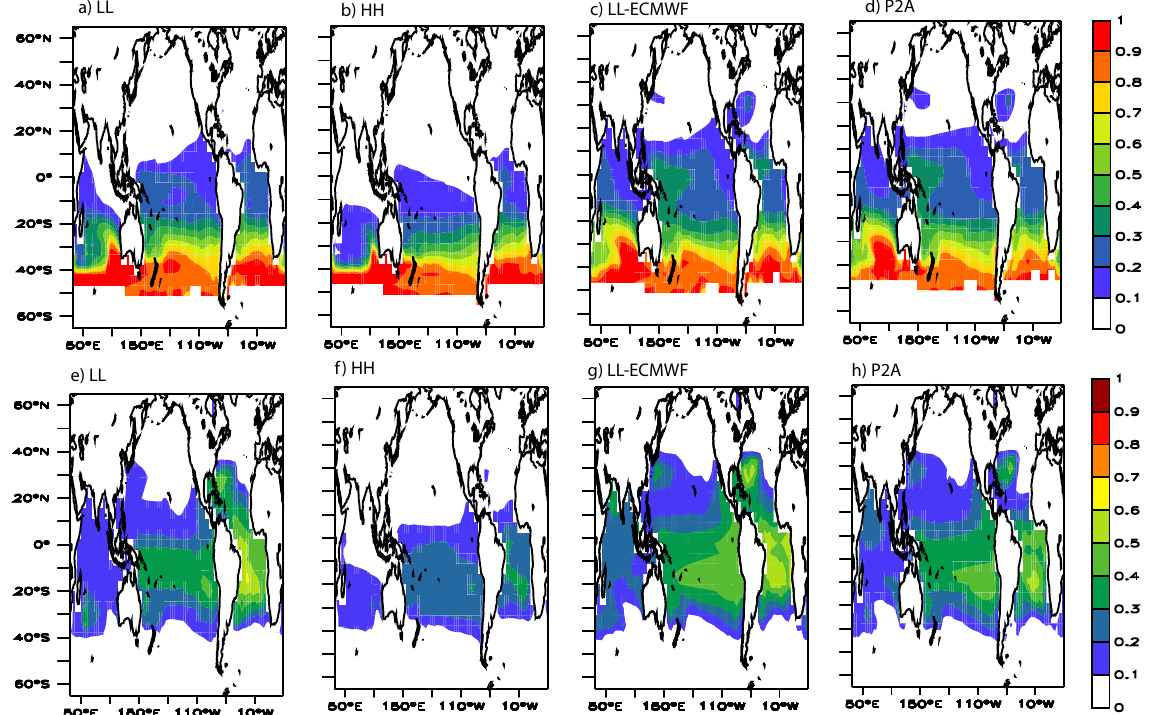
Fig. 10. The fraction of total phosphate above the 26.8 isopycnal comprised by unmodified SAMW phosphate (top panels) and remineralized SAMW phosphate (bottom panels) in the 4 models described in Table 2, as labeled at the top of each map. Unmodified SAMW phosphate is phosphate that comes directly from the tagging region without ever fueling productivity, while remineralized SAMW phosphate derives either from DOP tagged in the SAMW source region and remineralized to phosphate or SAMW phosphate that has fueled export production at least once (see Sect. 2.3 for